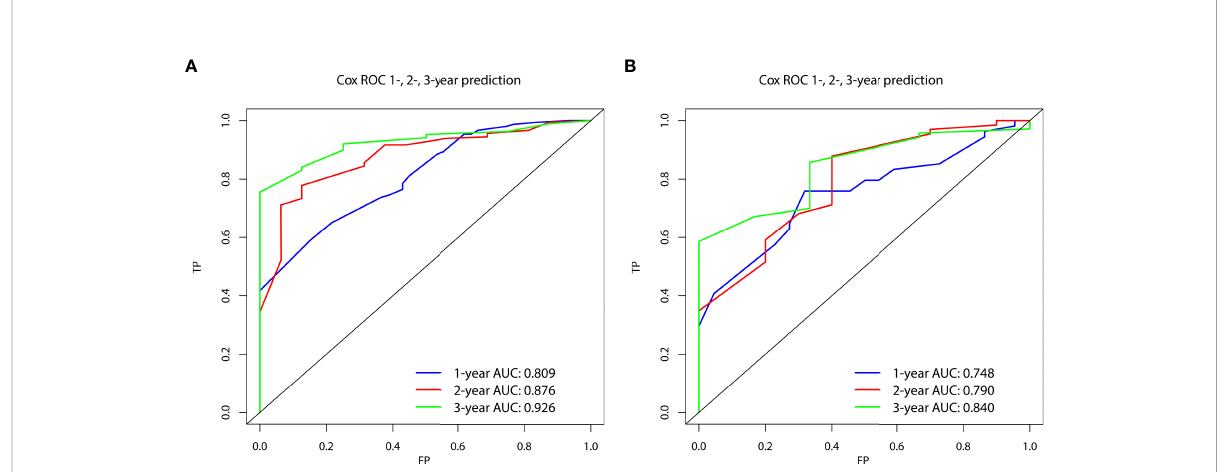
FIGURE 6 The time-dependent receiver operating characteristic (ROC) curves at 1, 2, and 3 years in the training group (A) and in the validation group (B) were used to evaluate the validity of the prognostic